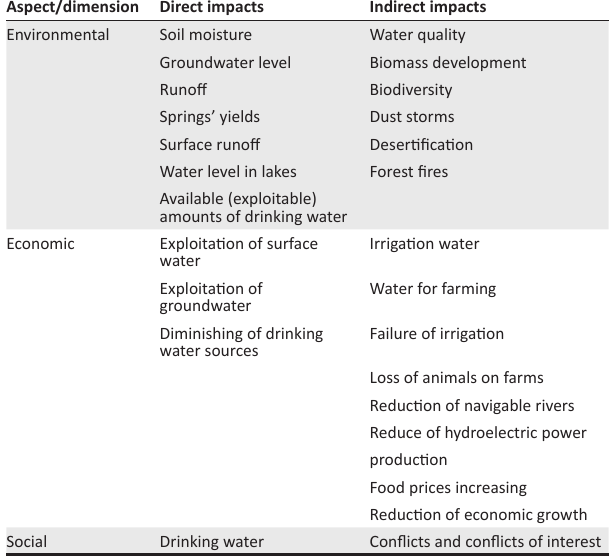
TABLE 1: Direct and indirect impacts of drought. Aspect/dimension Direct